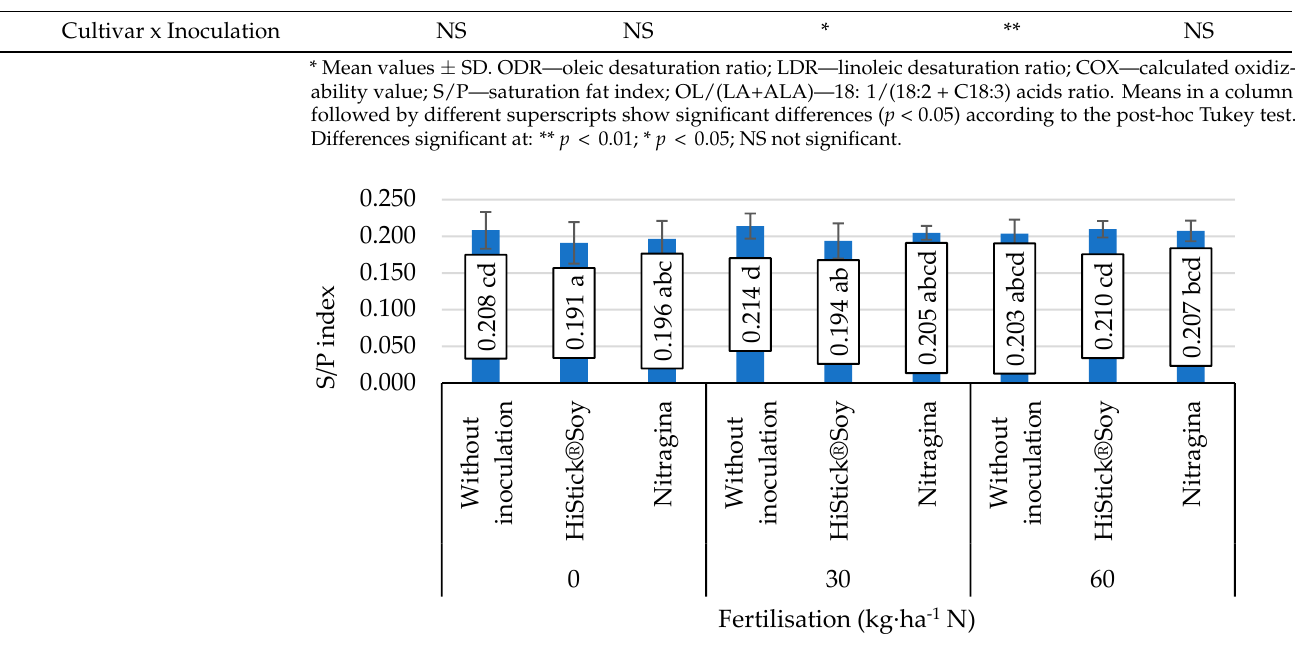
A significant interaction of cultivar and seed inoculation with B. japonicum bacteria Table 9. The ODR, LDR and COX indices and the S/P, OL/(LA+ALA) ratio of lipid quality in G. max was shown in the formation of the COX and S/P indices (Table 9). In the cv. Annushka seeds; mean values for interaction cultivar × seed inoculation. after application of the Nitragina bacterial preparation and in the variant without inocu- lation, the COX index reached significantly higher values compared to the cv. Aldana in- oculated with Nitragina, by 3.2 and 2.4%, respectively. In case of the S/P index, the highest value was obtained in the cv. Annushka in the control variant without inoculation, which was 12.9% higher than its lowest value found in seeds of the cv. Aldana treated with the HiStick ® Soy preparation.